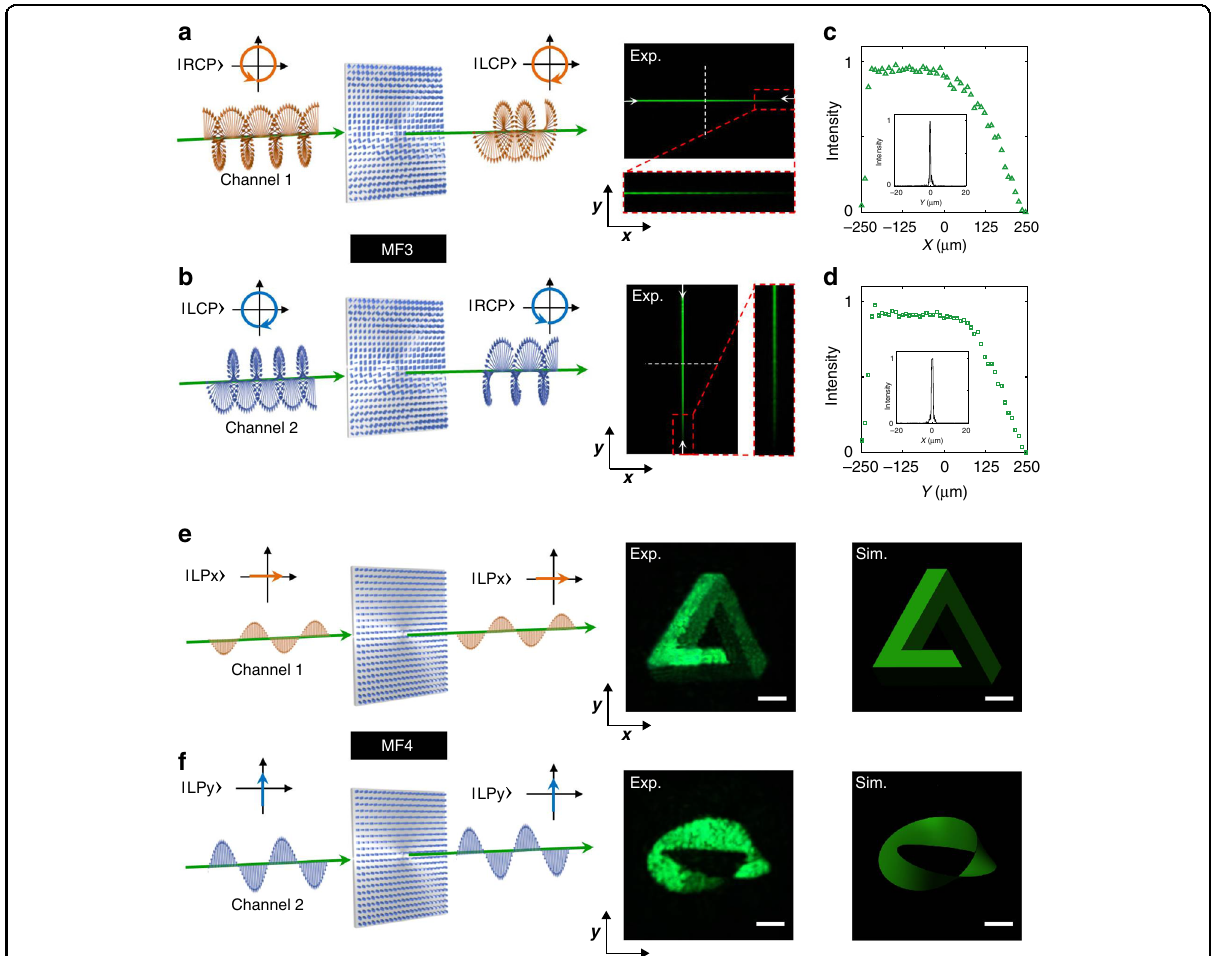
Fig. 4 Multifunctional metasurface devices enabled by independent amplitude and phase control for orthogonal polarization states. a , b Experimental demonstration of chirality-dependent cylindrical lens line focusing with nonuniform intensity distribution. The device is designed to focus RCP and LCP light to a line along the x -direction (right of a ) and y -direction (right of b ), along with a brightness gradient, at a focal length of ~0.5 and 1.0 mm, respectively. c , d Cross-sections of the measured RCP and LCP line foci along the x - and the y -directions (denoted by two white arrows of a and b ), respectively. Insets: intensity distributions of the middle of measured RCP and LCP line foci along y - and x- directions (denoted by dashed white lines of a and b ). e , f Experimental demonstration of polarization-dependent complex-amplitude holograms. Right: experimental and calculated intensity distributions of far- fi eld hologram images of “ Penrose triangle ” for x -polarized light ( e ) and “ Mobius strip ” for y -polarized light ( f ). Scale bar: 200 μ m. Experimental images were obtained at a propagation distance of z ≈ 5